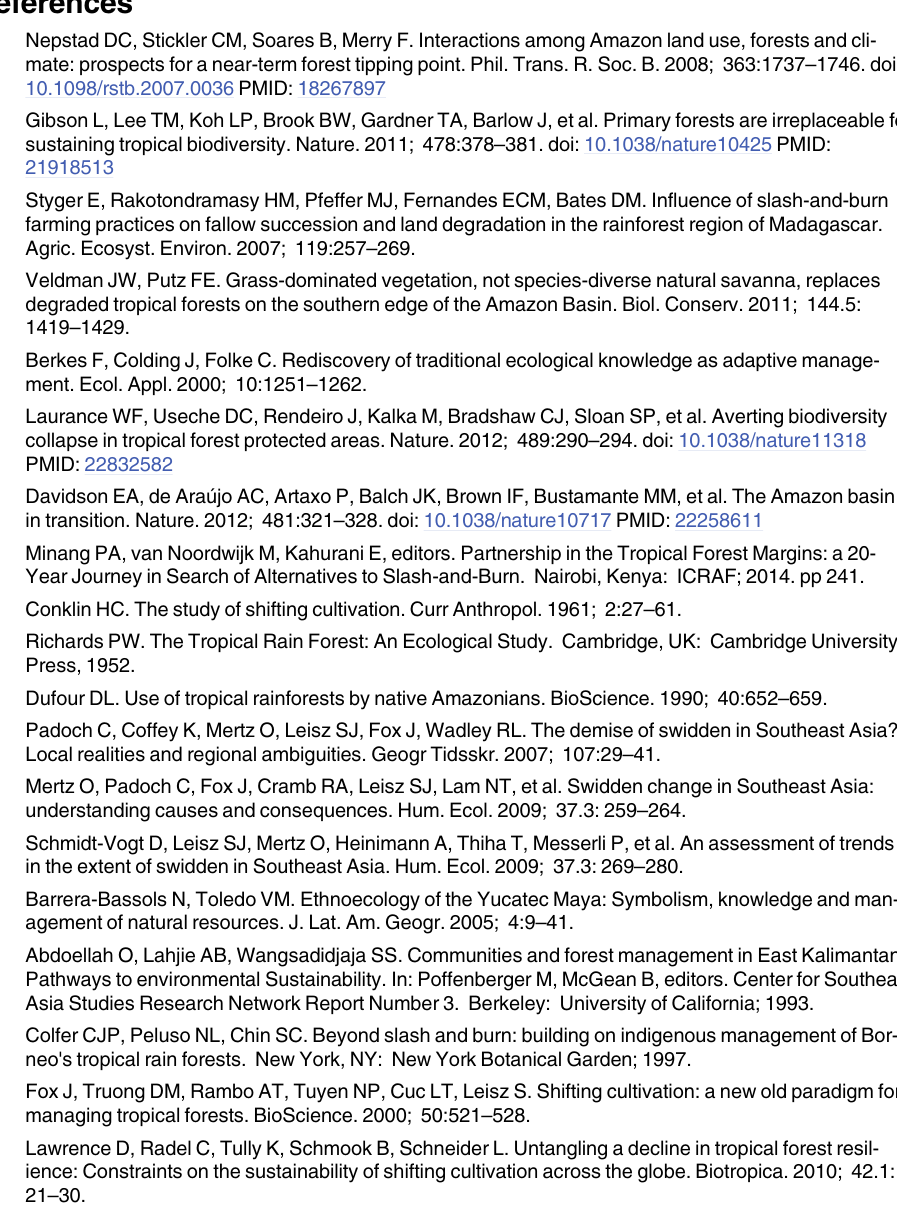
S2 Table. Agricultural productivity ( β i ) after clearing forest in stage i in six sites. (DOCX) S1 Supporting Information. Additional information about equations and parameters used in the